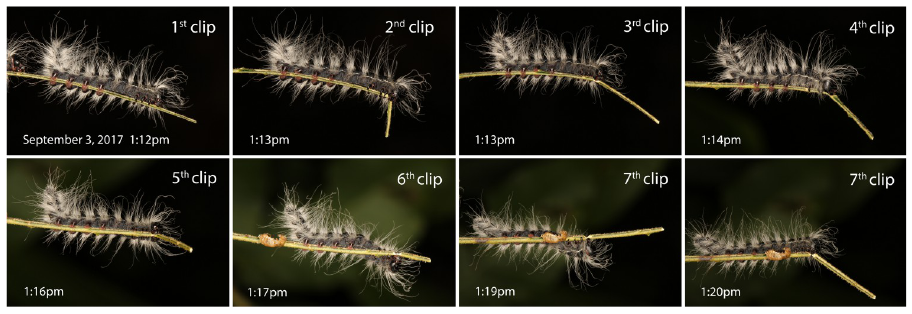
Fig 2. Final instar of Datana integerrima (Notodontidae) clipping a pecan leaflet in the field. The larva clipped the pecan midrib ( Carya illinoinensis , Juglandaceae), then backed up and clipped it again repeatedly for a total of seven clips in eight minutes. Each clip was approximately one cm closer to the base of the